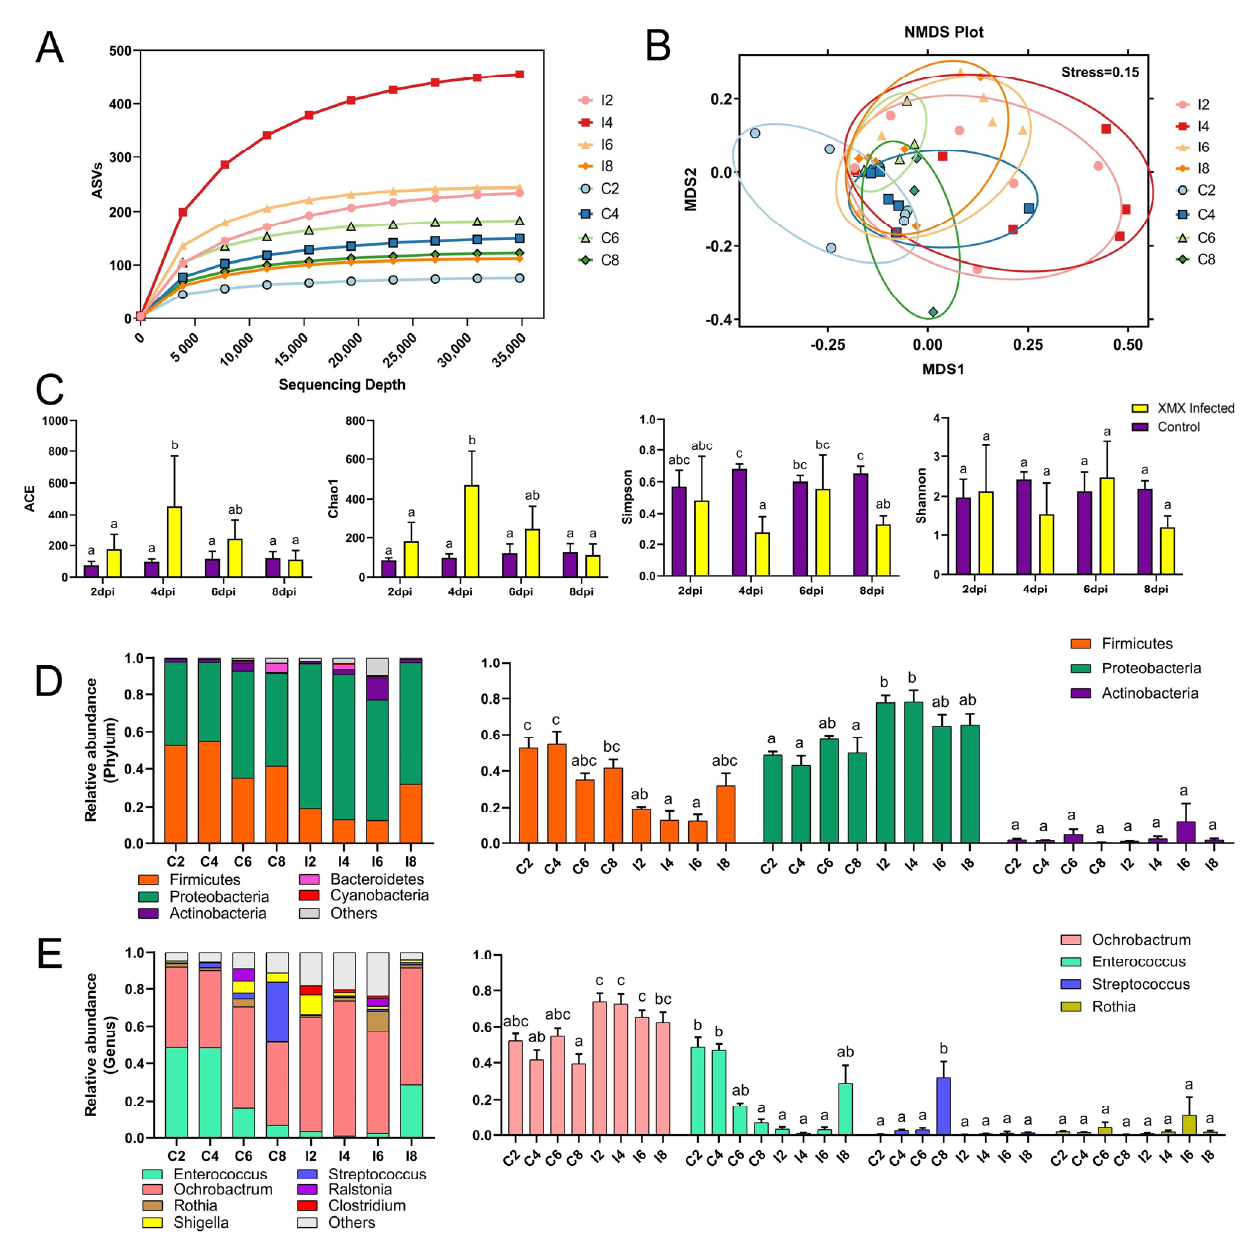
Figure 3. Effect of XMX infection on the diversity and component of ileal microbiota. ( A ) Rarefaction curve of the eight groups, and the horizontal axis represents the amount of sequencing data, the vertical axis represents the observed ASVs; ( B ) NMDS plot of the eight groups, each point in the plot represents a sample, the distance between points indicates the degree of difference, and the samples in the same group are represented by the same color. If the stress is less than 0.2, then NMDS can accurately reflect the degree of difference among samples; ( C ) α − Diversity of the eight groups; ( D ) Stacked bars represent the average relative abundance of the top 5 most abundant phyla within the ileum, “other” refers to the species outside the aforementioned top 5 phyla; ( E ) Stacked bars represent the average relative abundance of the top 7 most abundant genera within the ileum, “other” refers to the species outside the aforementioned top 7 genera. Different letters indicate significant differences.